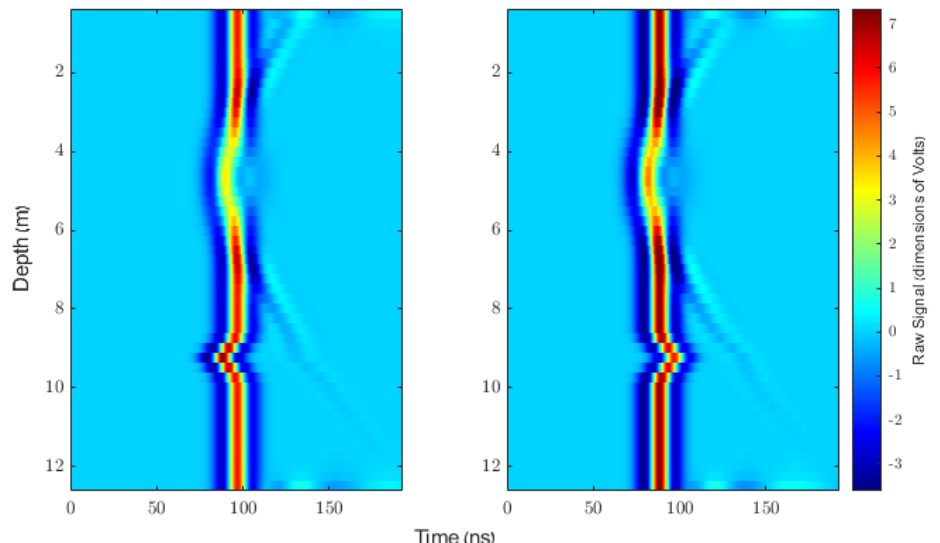
Figure 14. The profiles of the two simulations described in the text. In each case, the soil was homogenous soil with a relative permittivity of 10 and conductivity of 0.002 S/m. Measurements were simulated every 0.25 m. A cavity having a width of one meter exists between the depths of 3.85 and 5.5 m below the surface, and the borehole drift was most extreme at 9.25 m below the surface. The boreholes simulated in the left-hand profile converge, while the boreholes simulated in the right-hand profile diverge. The signals were cropped to show only the most relevant